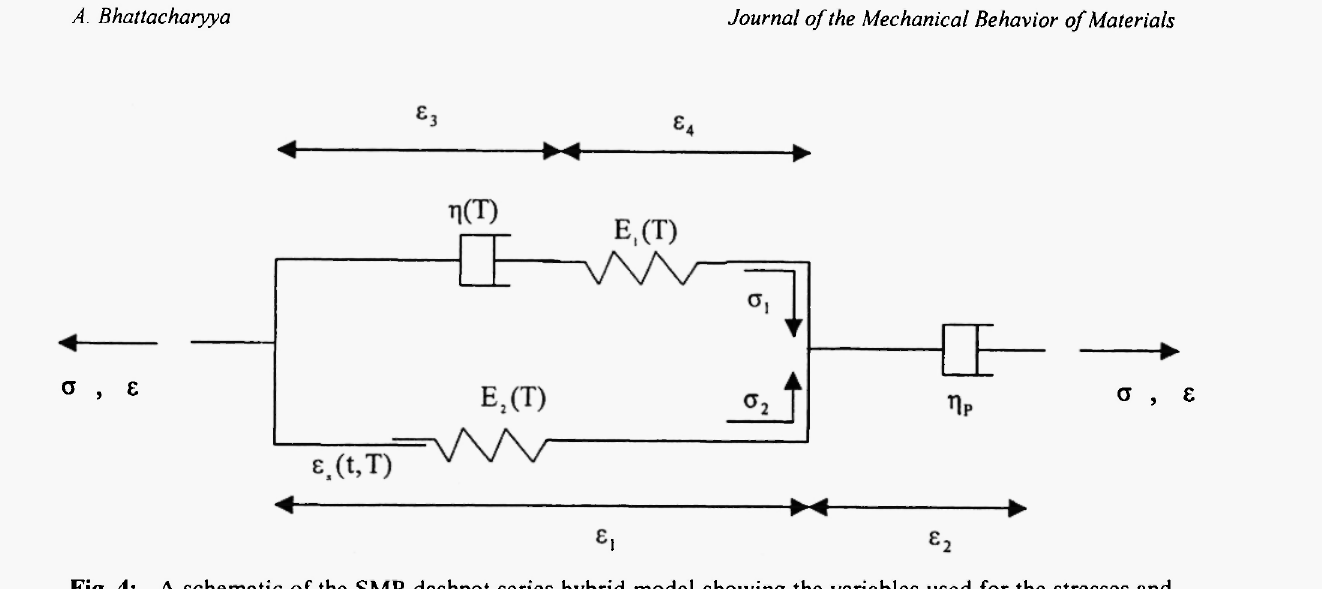
A schematic of the SMP-dashpot series hybrid model showing the variables used for the stresses and strains in the constituent elements. 5. The flowchart for the computational